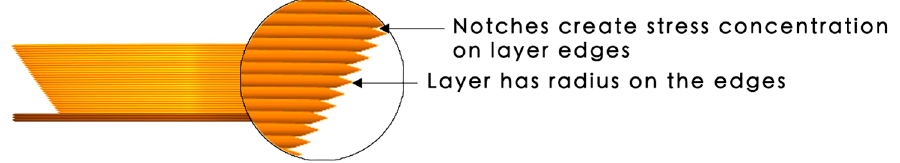
Figure 2. Explanation of the print layers from the ME process.